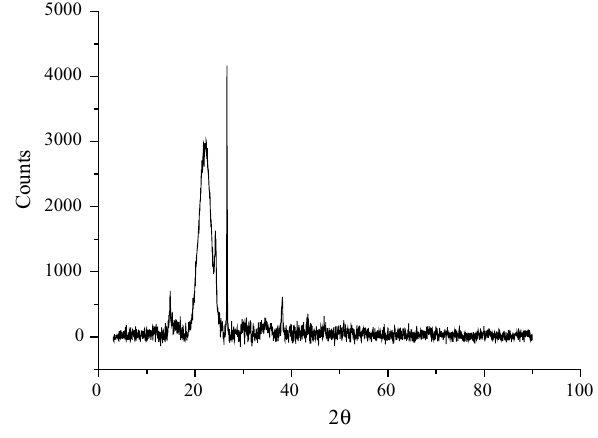
Fig. 2 XRD pattern of powdered Albizia lebbeck pods